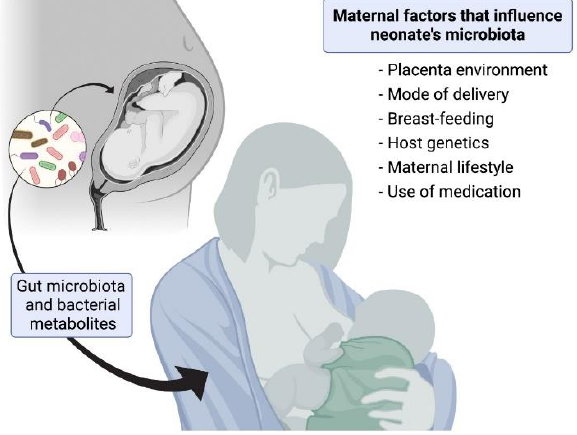
Figure 1. Maternal factors that influence neonate’s microbiota.